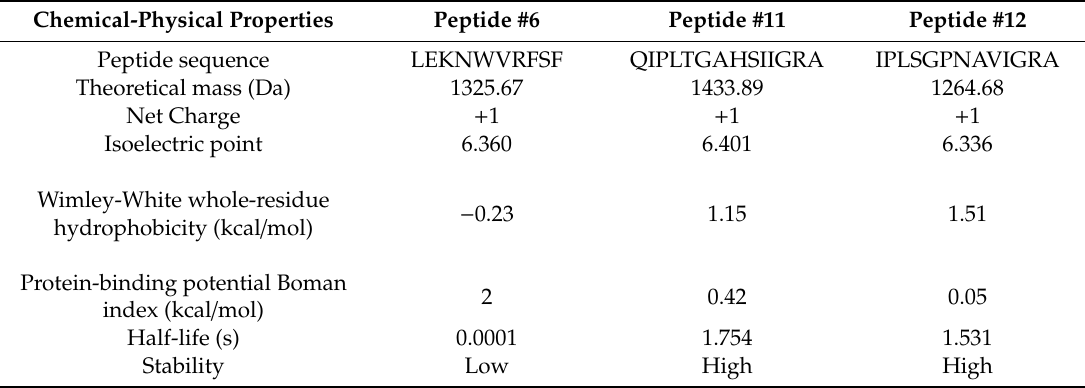
Table 3. Principal physicochemical parameters of the three potential AMPs #6, #11 and